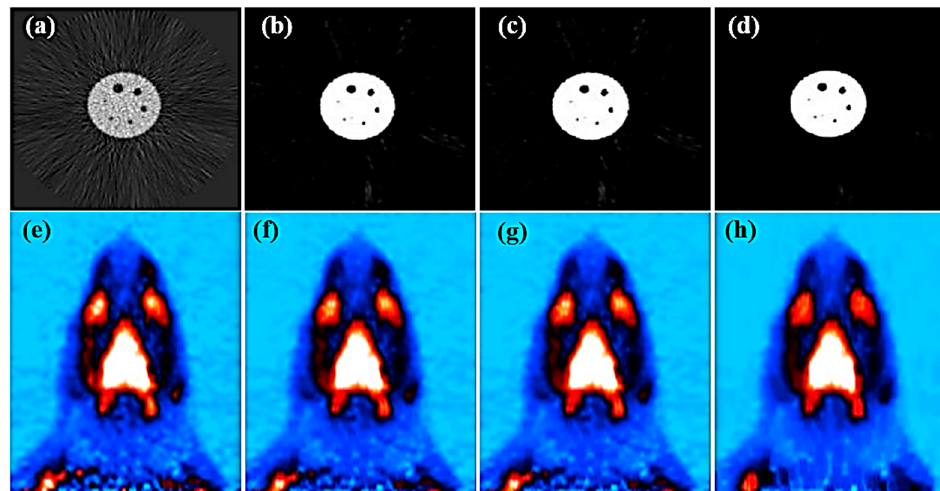
Figure 9. Demonstration the input images by MSO ORC operation on the FBP images for the Deluxe Jaszczak phantom ( a ) and a rat ( e ). A post-processing image by a 2D 3 × 3 MSO ( b , f ) and a 2D MSO with ORC ( c , g ). A post-processing image by a 3D 3 × 3 × 3 MSO with ORC ( d , h ). Notice that ( f , g ) were almost the same after 2D MSO with or without ORC in this study.